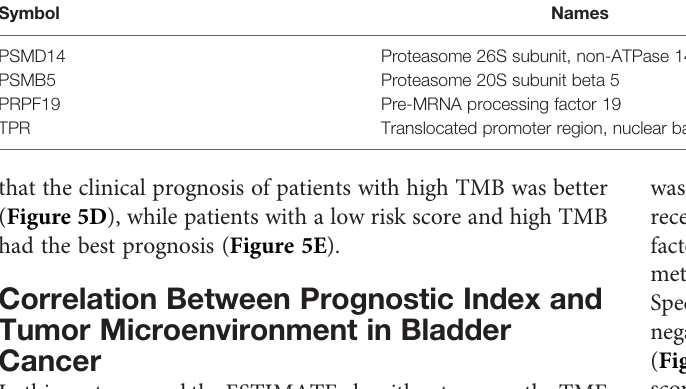
TABLE 2 | The detailed information and corresponding coef fi cient of the four cell senescence regulator genes.